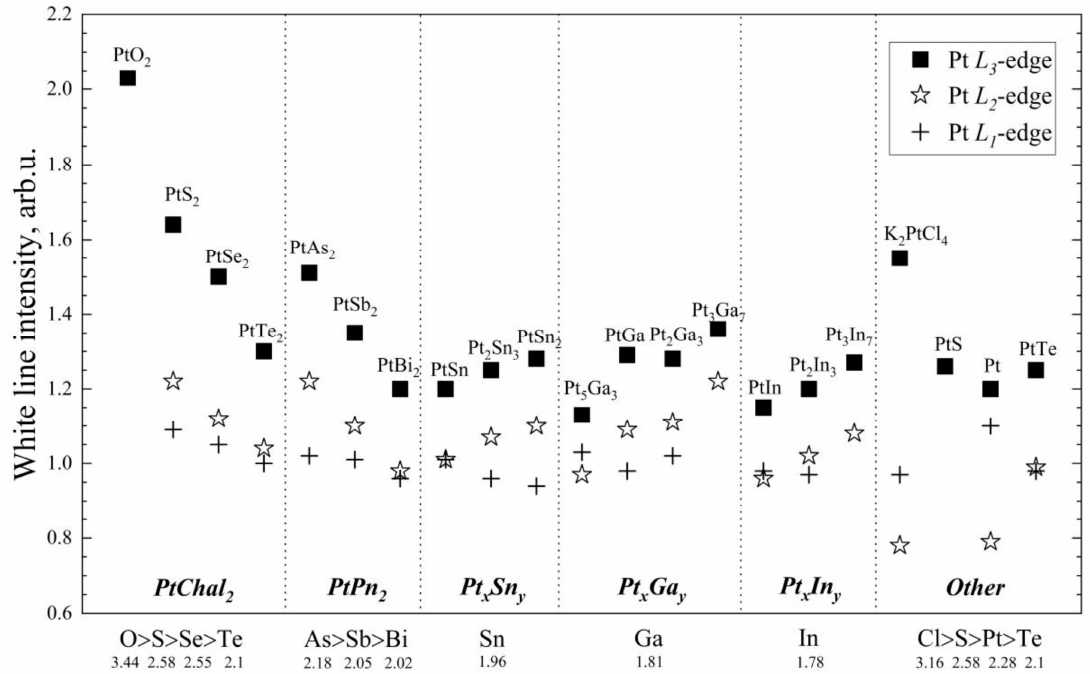
Figure 10. Plot showing normalized intensity of white line at the Pt L 1,2,3 -edges. The ligand electronegativities are indicated in the X axis.